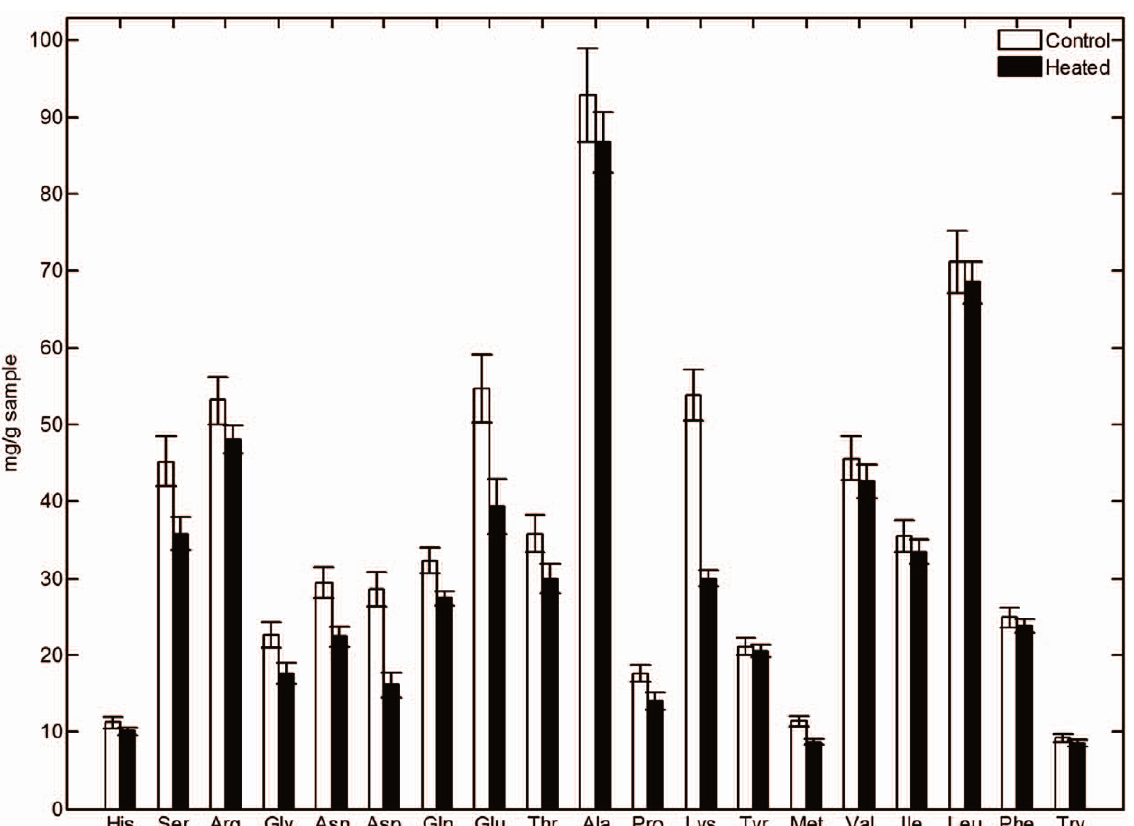
Figure 7. Amino acid analysis results obtained by enzymatic digestion, comparing a control (methanol treated) honeybee silk sponge sample to a methanol treated sponge sample heat treated at 190 6 C for 60 minutes.